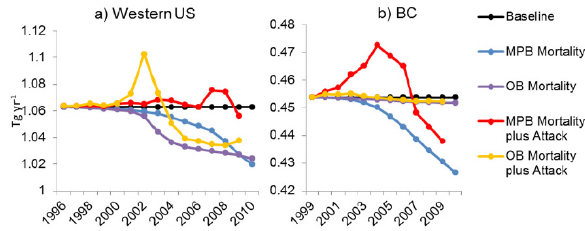
Fig. 6. Time series showing evolution of the simulated total re- gional monoterpene emissions (sum of 3-carene, β -pinene, β - phellandrene, p-cymene, α -pinene, and sabinene) affected by moun- tain pine beetle (MPB) and other bark beetle (OB)-caused tree mor- tality in (a) western US and (b)